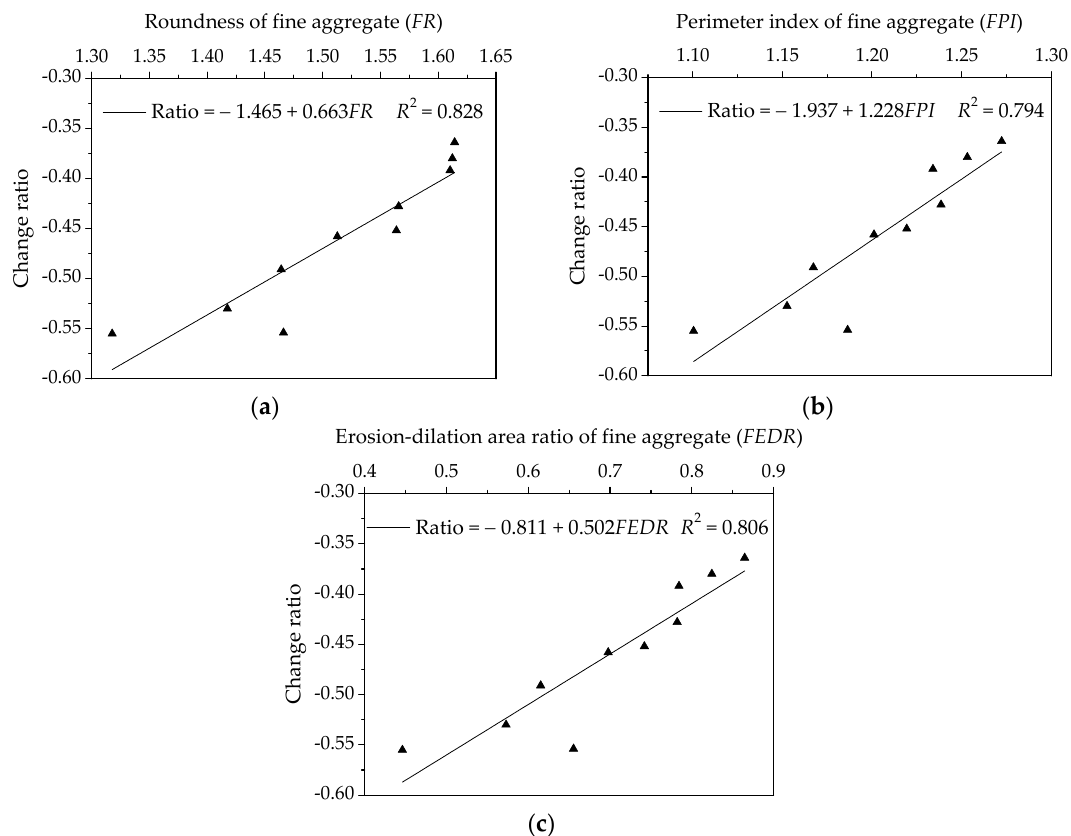
Figure 17. Influences of fine aggregate morphological characteristics of on change rate of relaxation modulus for asphalt mortars: ( a ) Shape ( FR ); ( b ) Angularity ( FPI ); and, ( c ) Texture ( FEDR ).